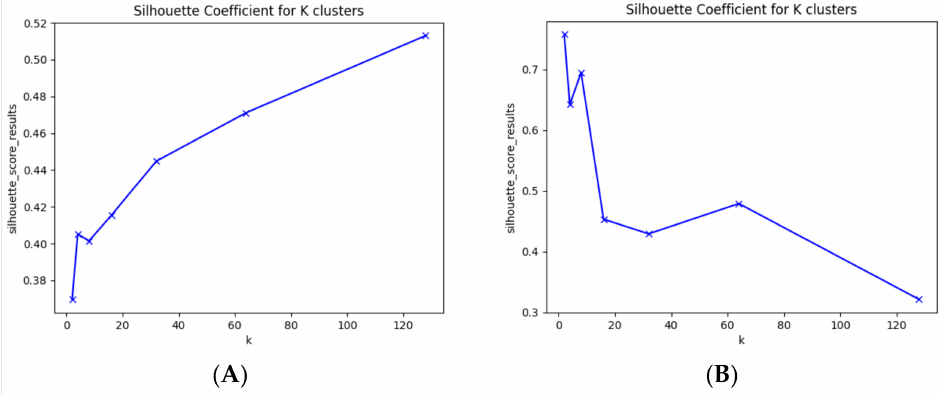
Figure 7. Example of approaches performance through multiple Ks. ( A ) Maximizing in 128 clusters, ( B ) Maximizing in 2